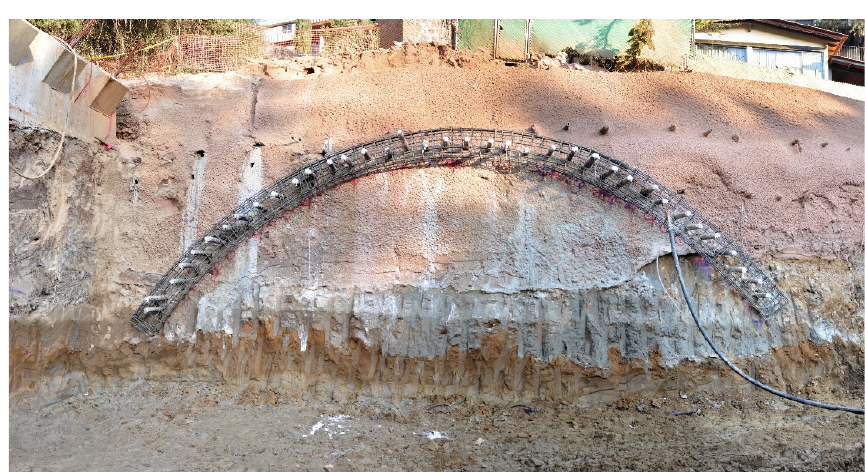
Figure 4. Micropiles umbrella with reinforced steel structure in the south portal of the tunnel.